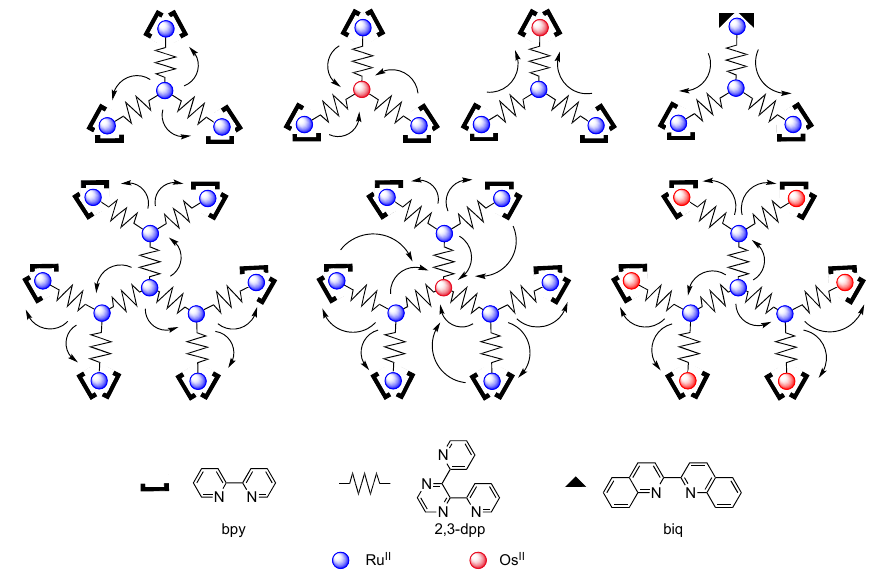
Figure 39. Schematic representation of the energy transfer in polynuclear complexes bearing 2,3-dpp bridging ligands